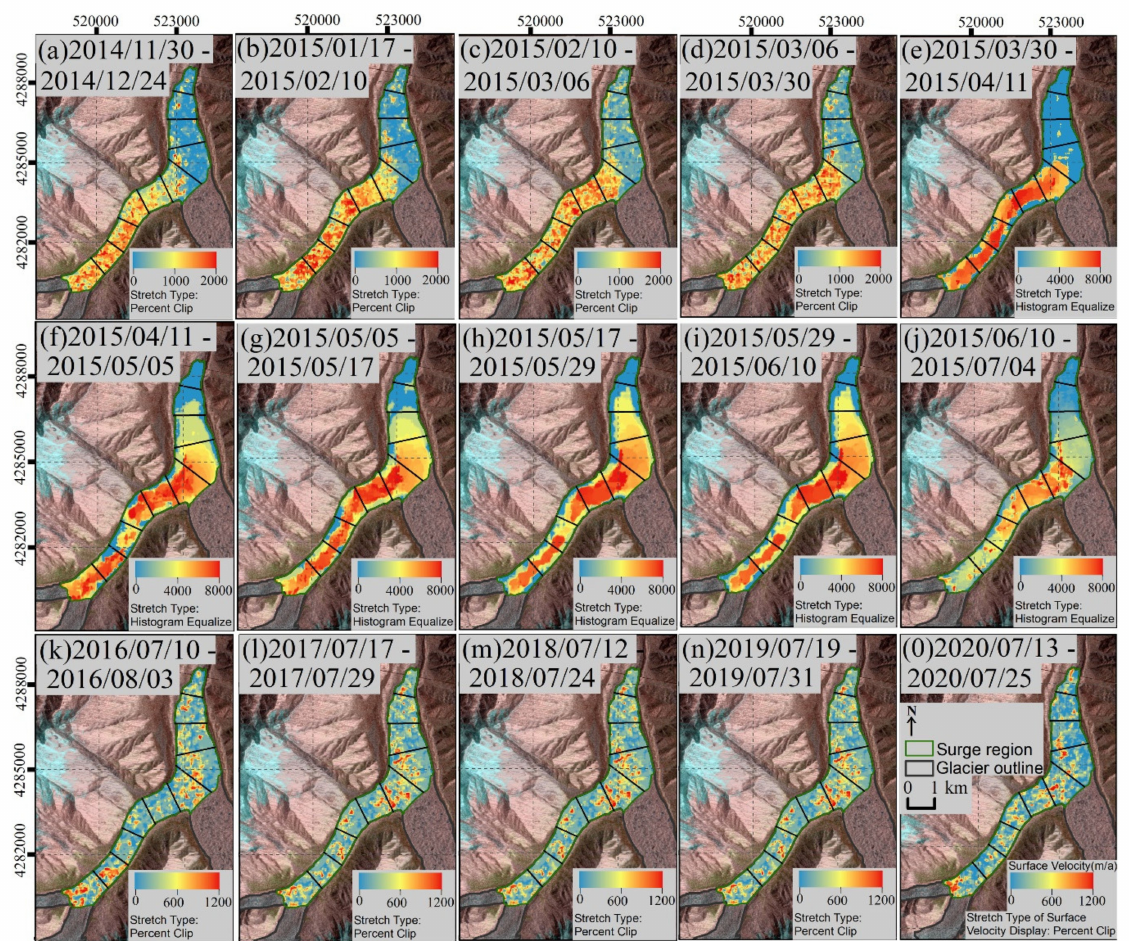
Figure 6. Surface velocities retrieval results of most phase from 13 October 2014 to 4 July 2015 (panel ( a – j )) and each July from 2016 to 2020 (panel ( k – o )). Due to the large span of velocity, especially in the surge phase, the values are displayed in different stretch types, including histogram equalize and percent clip. The legend and north arrow are shown in the panel ( o ). The background image is Landsat 8 scenes acquired on 11 July 2015. All coordinates are in UTM WGS84 Zone